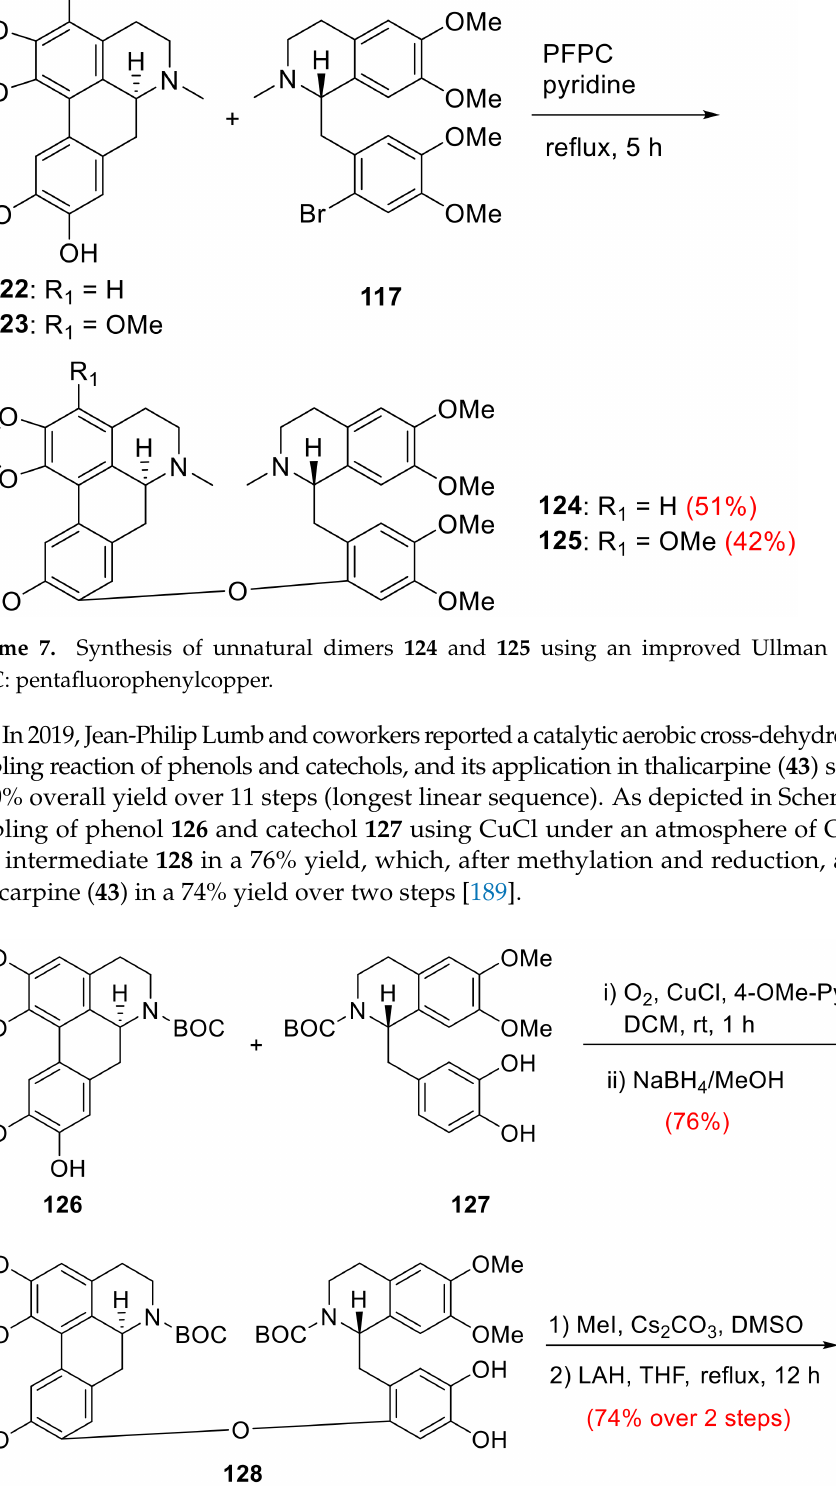
Py: pyridine; DCM: dichloromethane; DMSO: dimethylsulfoxide; LAH: lithium aluminum hydride; THF: